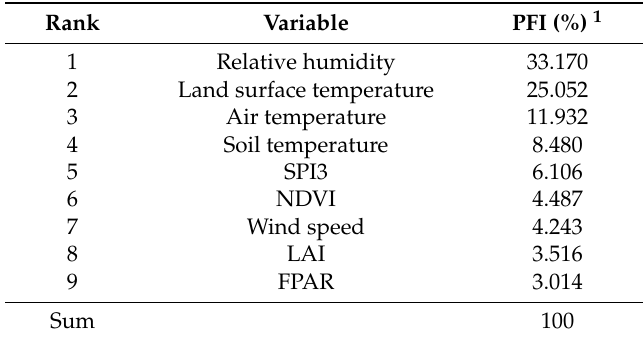
Figure 7. Relationships between wind speed and the estimation error of ET 0 . No correlation was found between them. 4.2. Spatial and Temporal Characteristics of the Accuracy Statistics For a more detailed examination of the daily ET 0 retrieval, the accuracy statistics were summarized according to location, year, and month. Table 4 shows the accuracy associated with the nine stations in the croplands of South Korea used for in situ measurements. Station 177 was associated with the highest accuracy, with the MAE of 0.703 mm/day, the RMSE of 0.955 mm/day, and the CC of 0.896, whereas station 254 results were the least accurate, with the MAE of 0.878 mm/day, the RMSE of 1.144 mm/day, and the CC of 0.833. The overall accuracy of the daily ET 0 was similar among the nine stations because the ET 0 is not affected by the local condition of the land surfaces. Figure 8 shows scatterplots for the nine stations, in which data trends are generally in accordance with the 1:1 line.